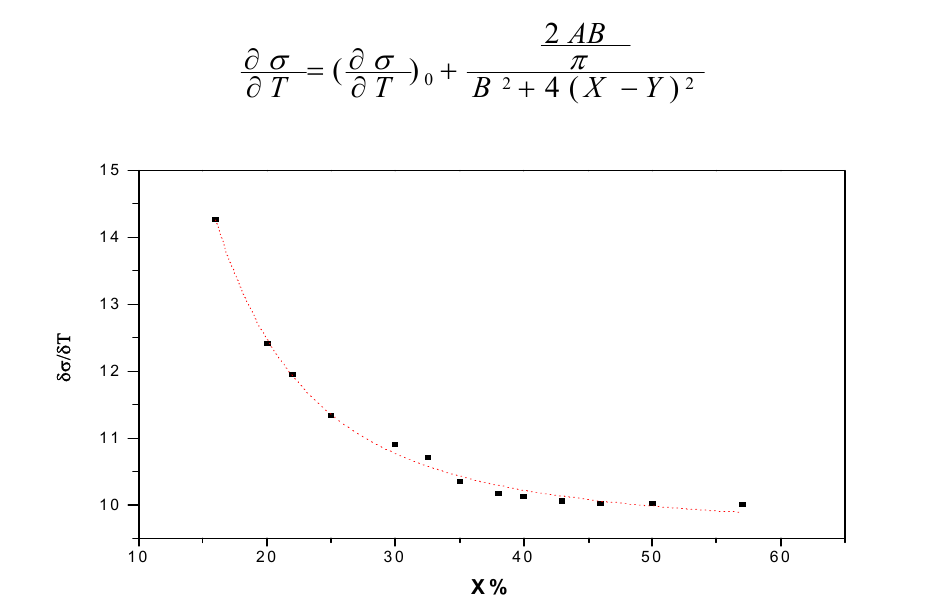
Figure 2. Thermal derivative ∂σ / ∂ T vs composition X of acid for the mixture isobutyric acid – water (I-W). Dashed line represents the theoretical behavior, in the poor region of acid, ∂σ / ∂ T decreases